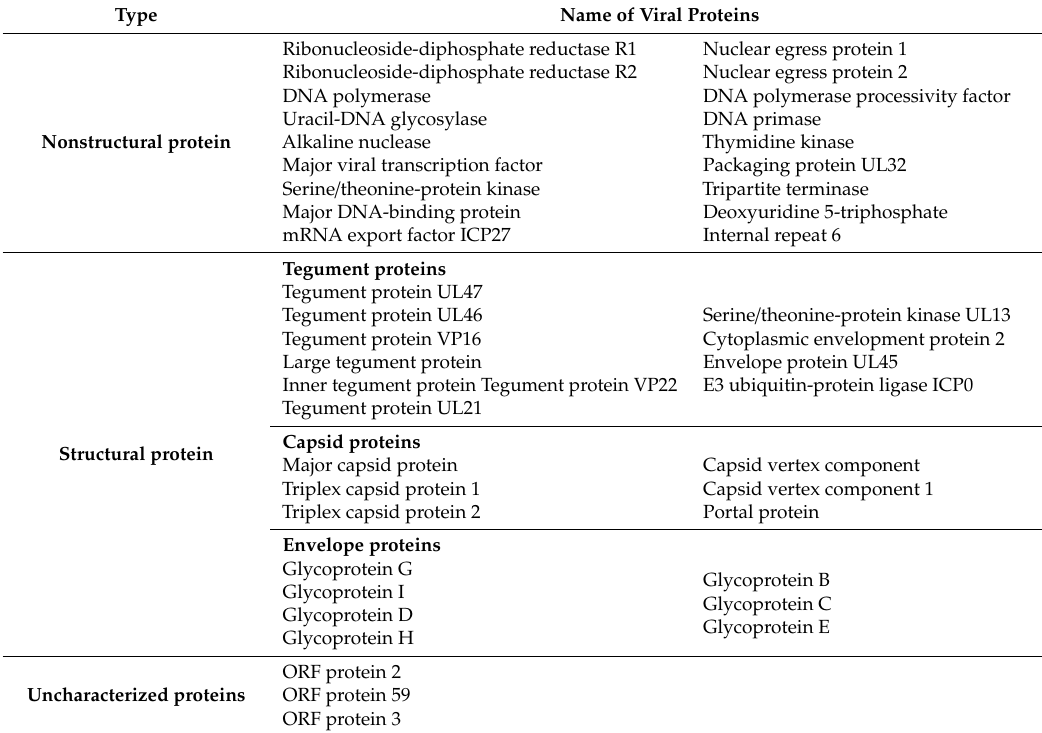
Table 3. Classification of EHV-1 proteins quantified in infected PBMC at 24